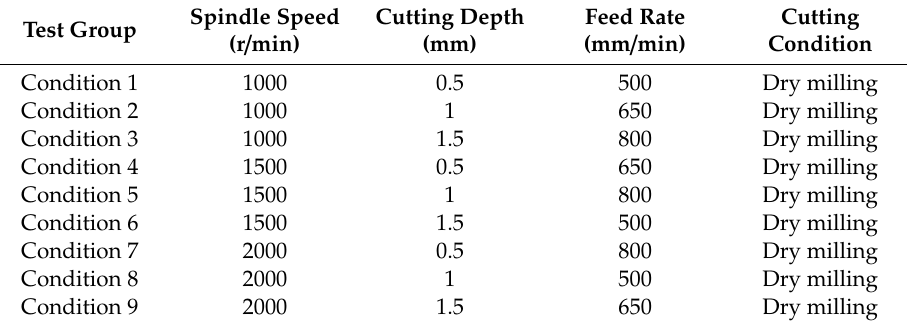
Table 4. Division of the tool wear stages. VB: maximum width of the wear land. Wear Stage